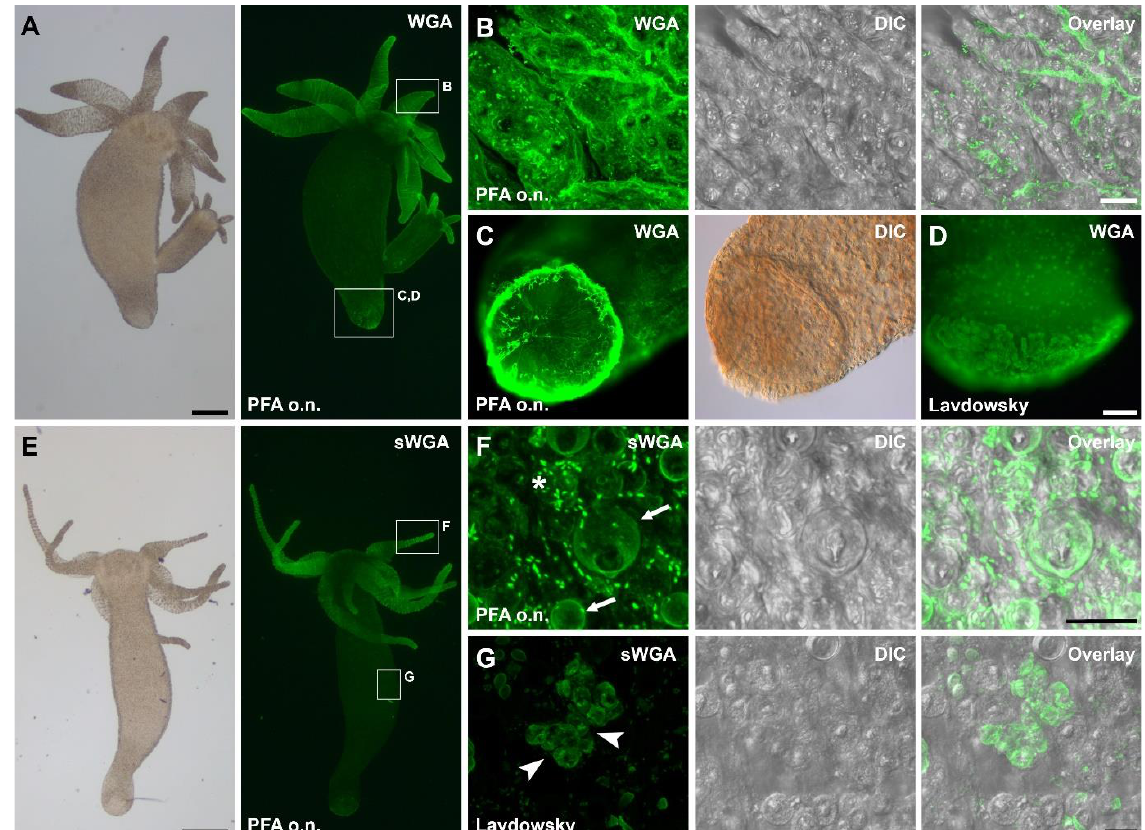
Figure 2. Lectin labeling of Hydra whole-mounts with ( A – D ) WGA and ( E – G ) sWGA. ( A ) WGA and ( E ) sWGA labeling of whole-mount individuals. ( B , F ) Overall ectoderm surface, ellipsoid structures, nematocytes capsules, and operculum were labeled with both lectins. Basal disc surface staining for ( C ) overnight PFA and ( D ) Lavdowsky fixatives. Note that the intensity and the pattern of the disc surface staining varied among individual Hydras , without relying on the fixation method. ( G ) After Lavdowsky fixation, developing nematoblasts and nematocytes were labeled in the body column for both lectins (sWGA is shown in the figure). Arrows highlight nematocytes and arrowheads point towards developing nematoblasts. The asterisk indicates ellipsoid structures. The fixation method used is indicated in the images. Scale bars: ( A , E ) 500 µm; ( C , D ) 100 µm; ( B , F , G ) 20 µm.